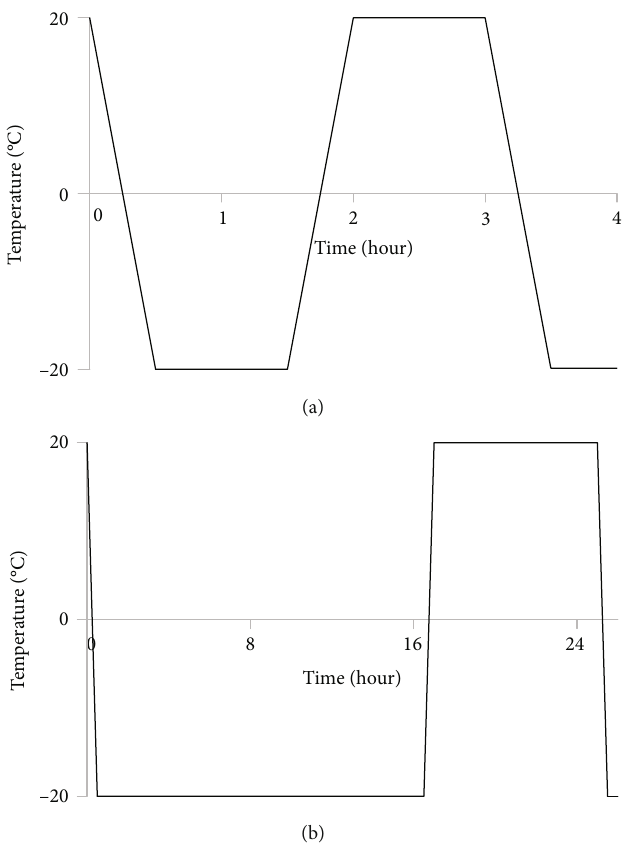
Figure 2: Standard-speci fi ed temperature controls in CFT test on (a) thermal-insulation products and (b) external thermal insulation composite